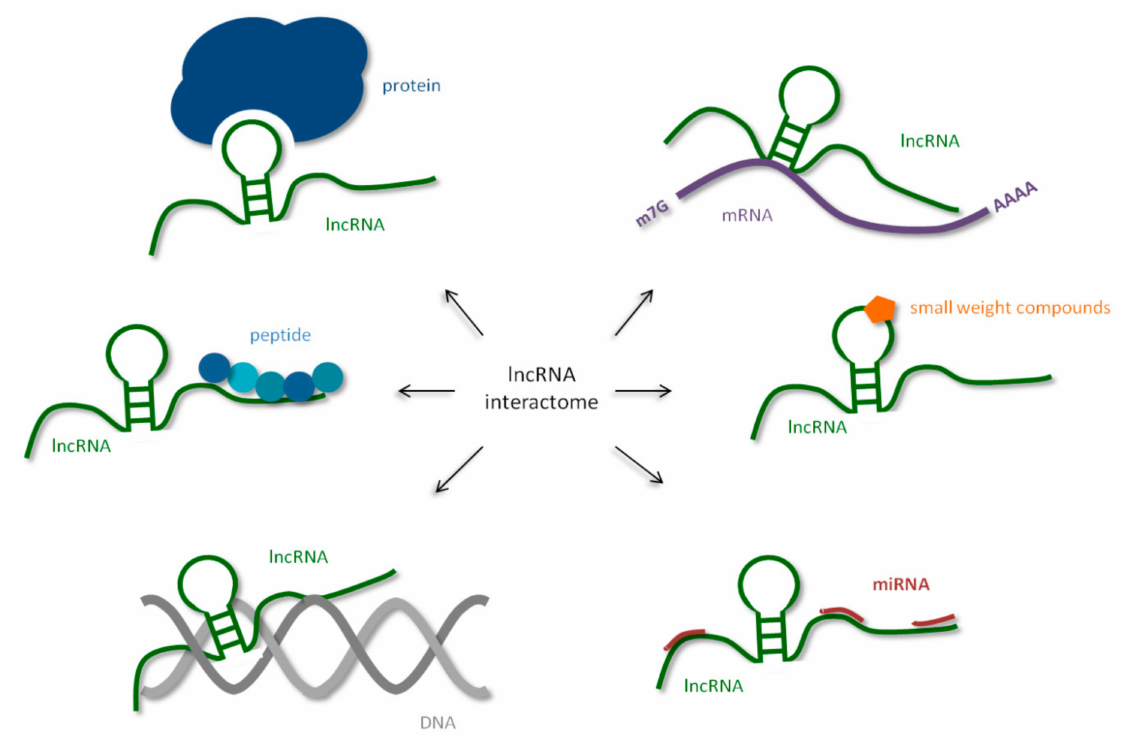
Figure 1. Human long non-coding RNAs (lncRNA) interactome, interaction of human lncRNA with cellular